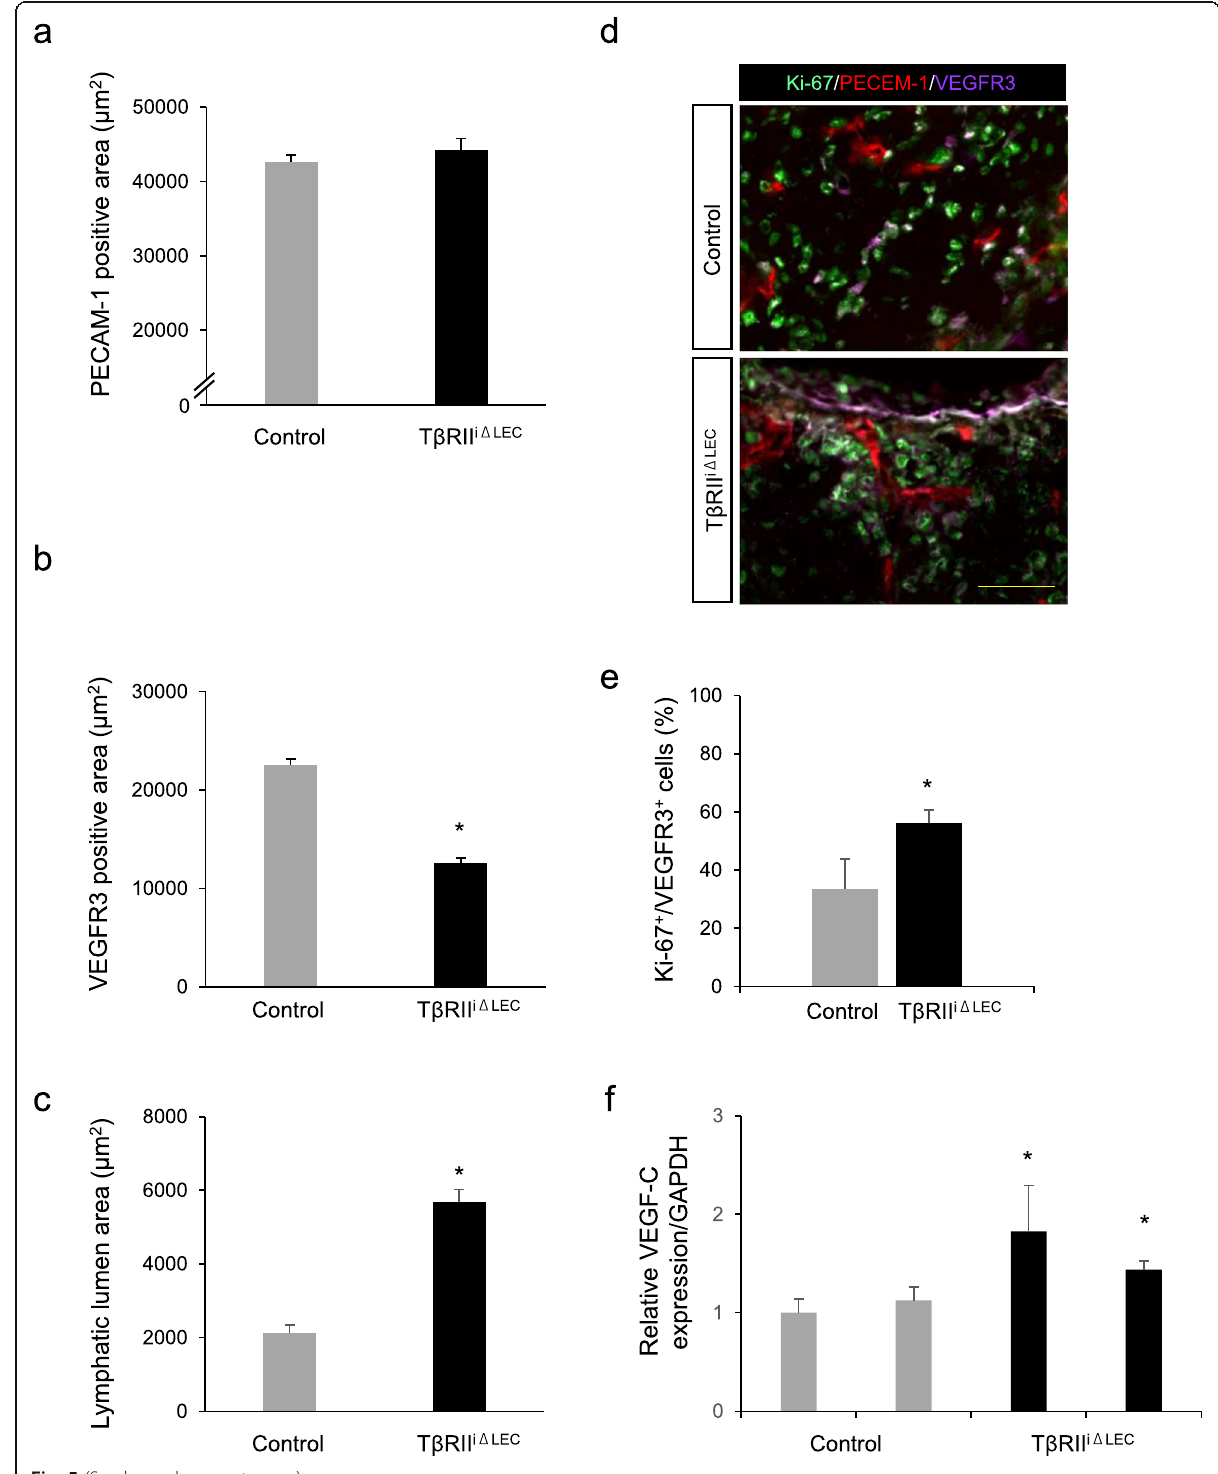
Fig. 5 (See legend on next